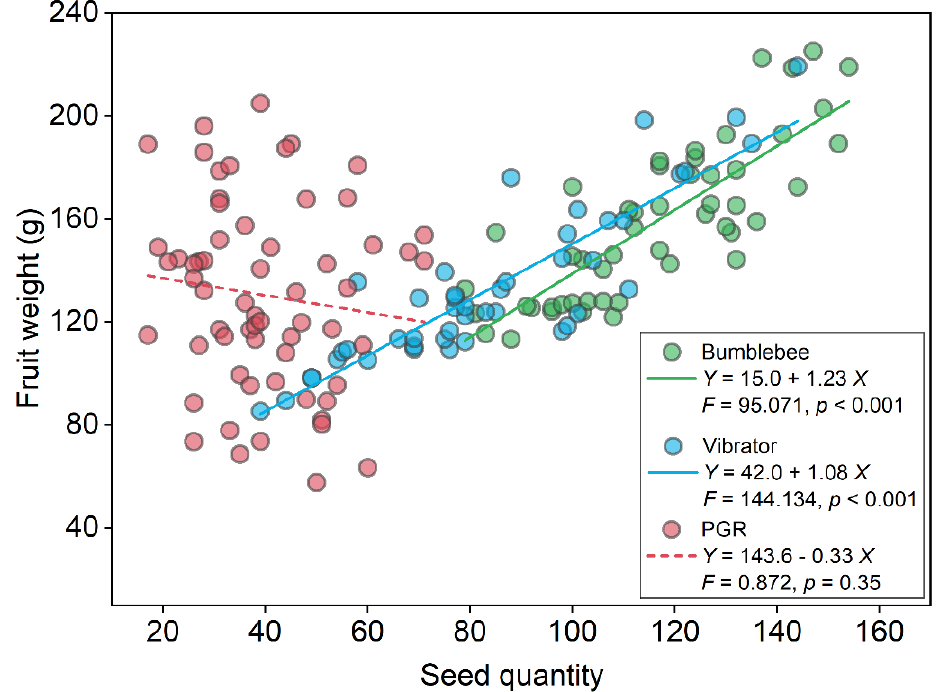
Figure 4. Fruit weight in relation to seed quantity of tomato fruit by different pollination treatments. Solid and dashed lines indicate significant and nonsignificant partial regressions, respectively.